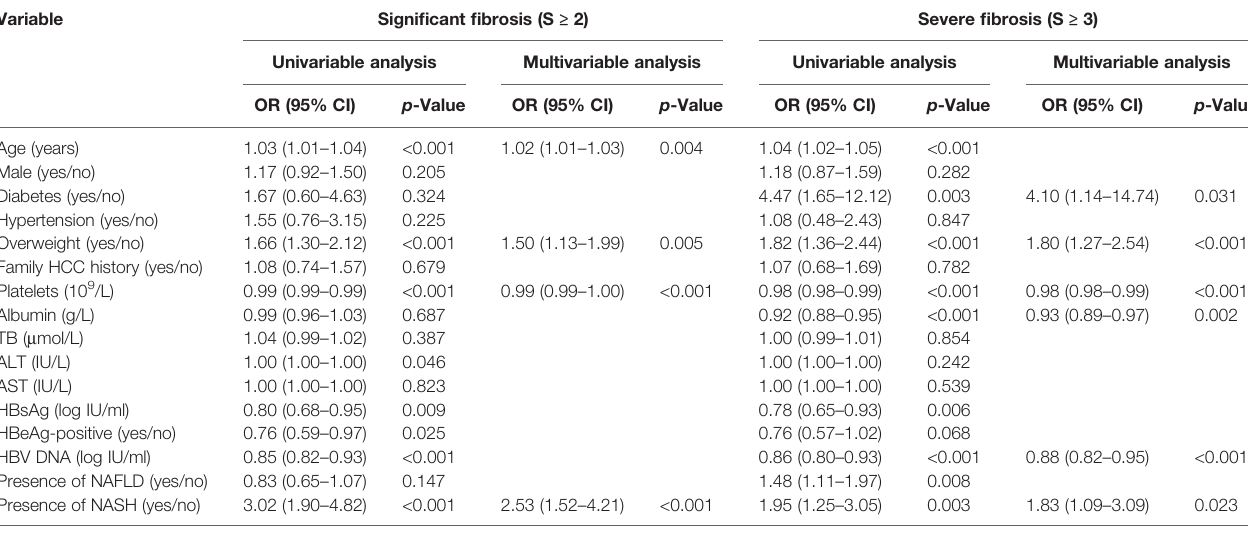
TABLE 2 | Factors associated with signi fi cant fi brosis and severe fi brosis among patients with chronic HBV infection. Variable